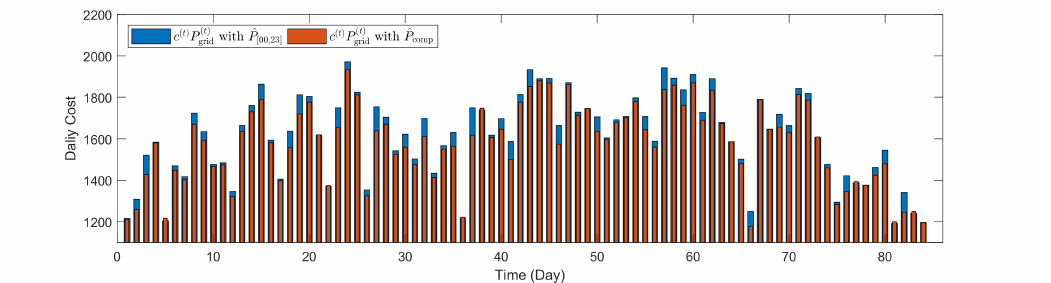
Figure 16. Daily cost for total test data.